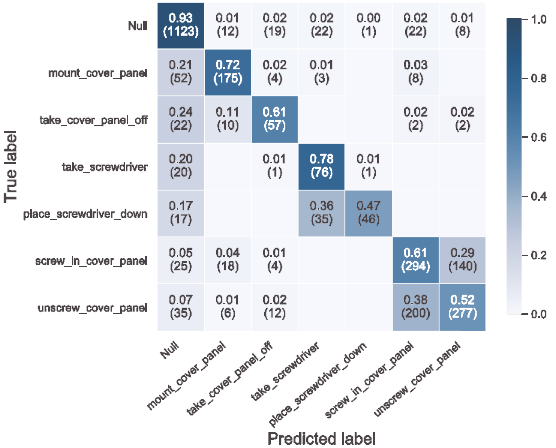
Fig. 2. Confusion matrix of C-DRNN on the OCA dataset.